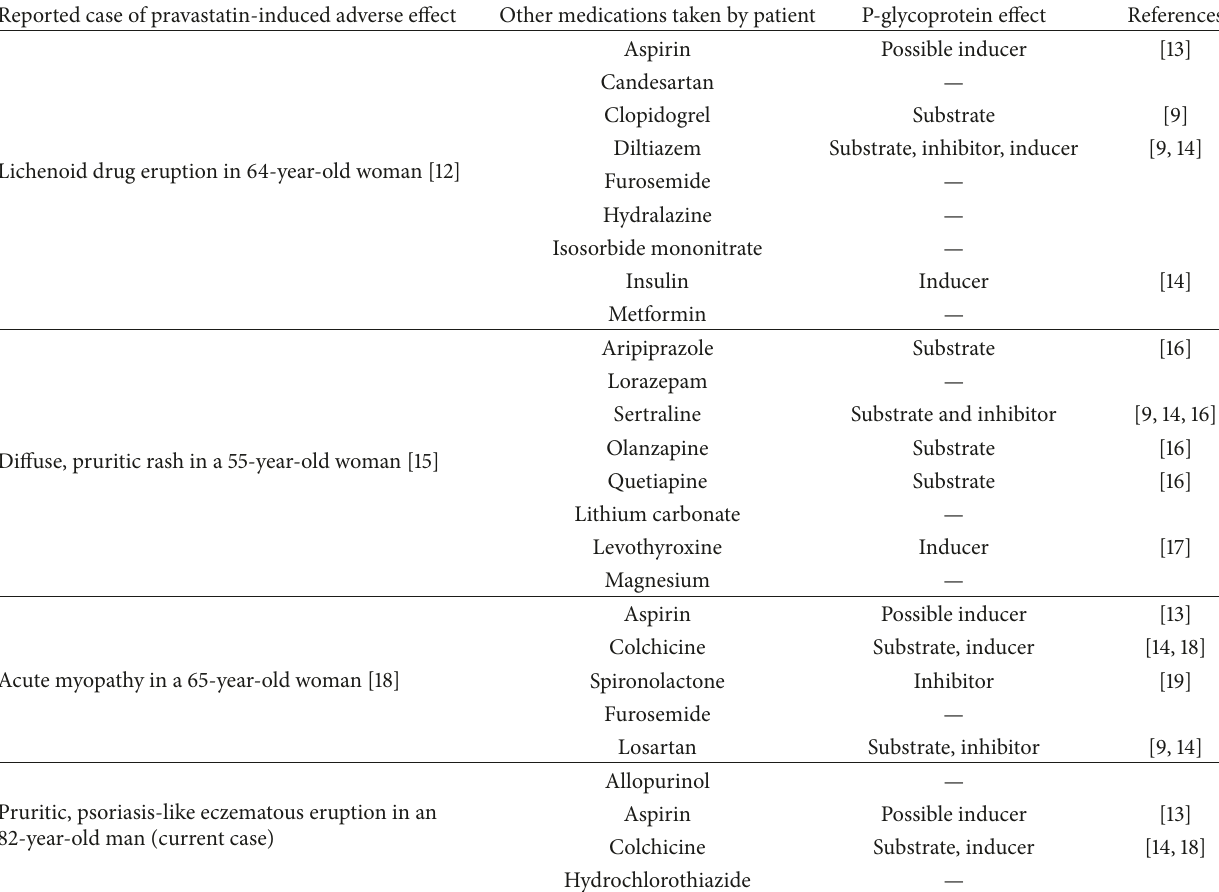
Table 1: Cases of pravastatin-induced adverse effects and P-glycoprotein